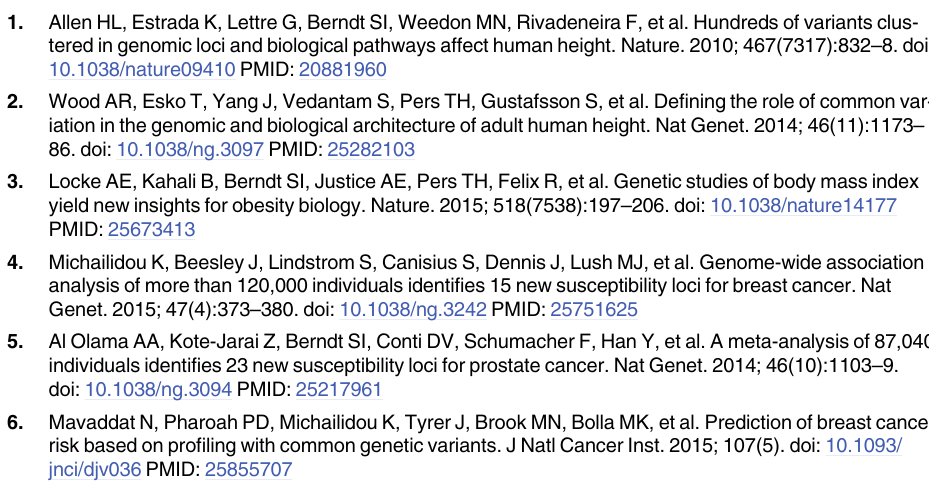
S2 Fig. The prediction R2 for four diseases with large-scale discovery samples.